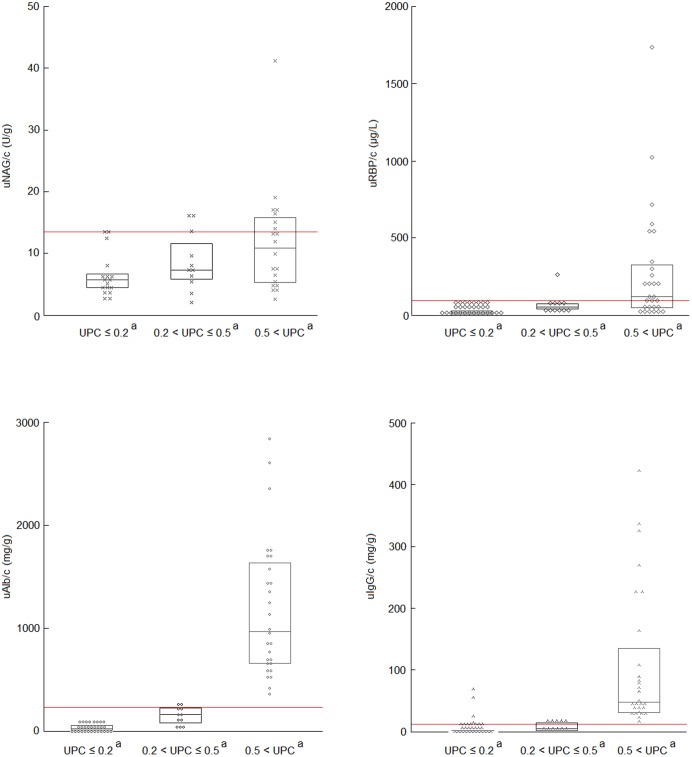
Distribution of the values for the four urinary marker ratios depending on UPC subclass.The bottom and top of the box indicate the 25th and 75th percentile respectively and the horizontal line inside the box shows the median distribution. Red lines represent upper “health” thresholds. When the letter in superscript is similar, a significant difference exist between group (p<0.001)